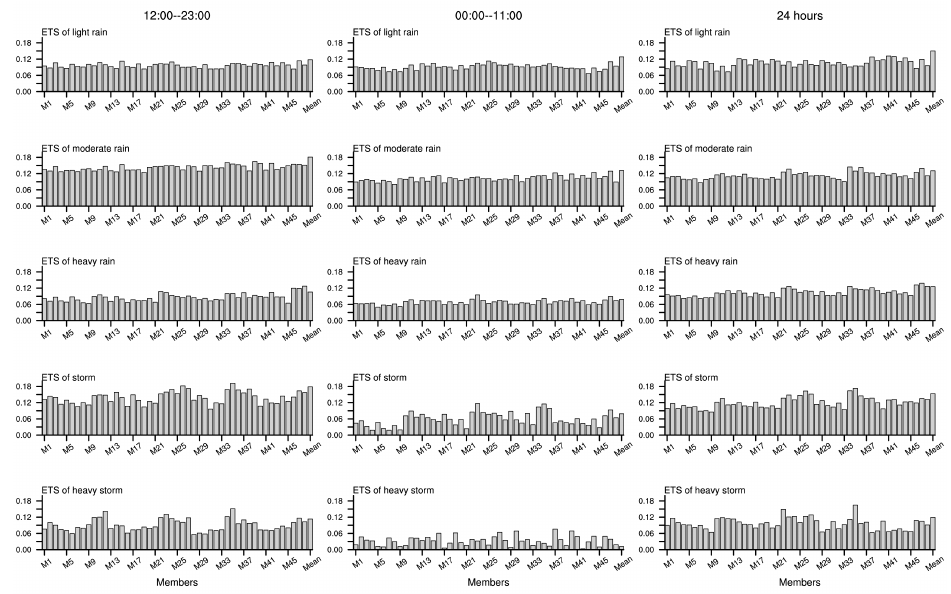
Figure 8. The average ETS of light rain ( the first row ), moderate rain ( the second row ), heavy rain ( the third row ), storm ( the fourth row ), and heavy storm ( the fifth row ) for each ensemble member in four rainfall cases during 12:00–23:00 UTC ( the first column ), 00:00–11:00 UTC ( the second column ), and 24 h ( the third column ), respectively. “Mean” denotes the ensemble mean.